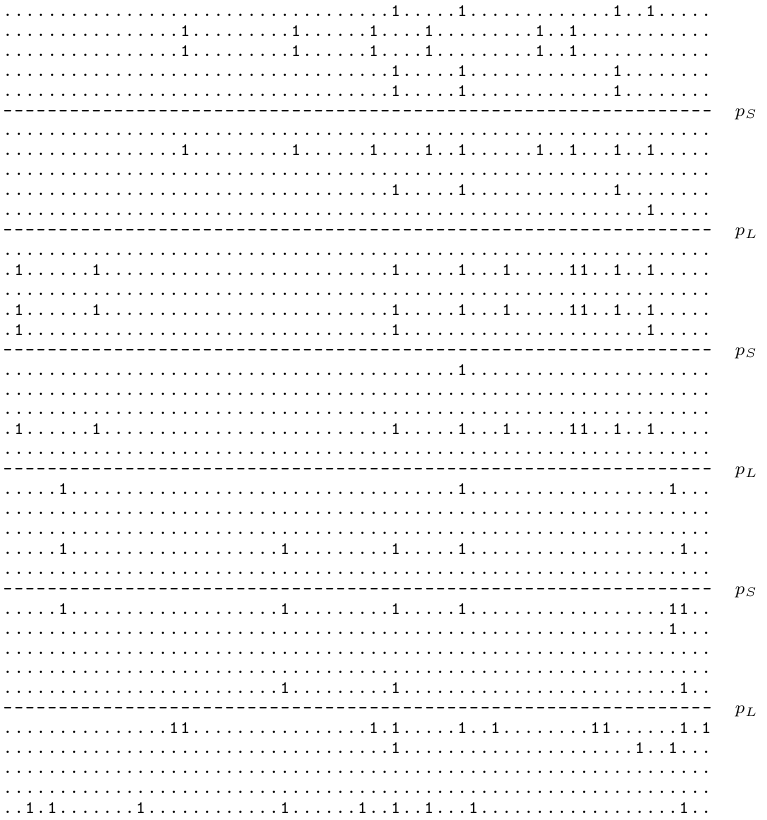
Figure 8: 4-round trail with 44 [10, 9, 6, 19] active Sboxes and weight 123 [20, 36, 19,